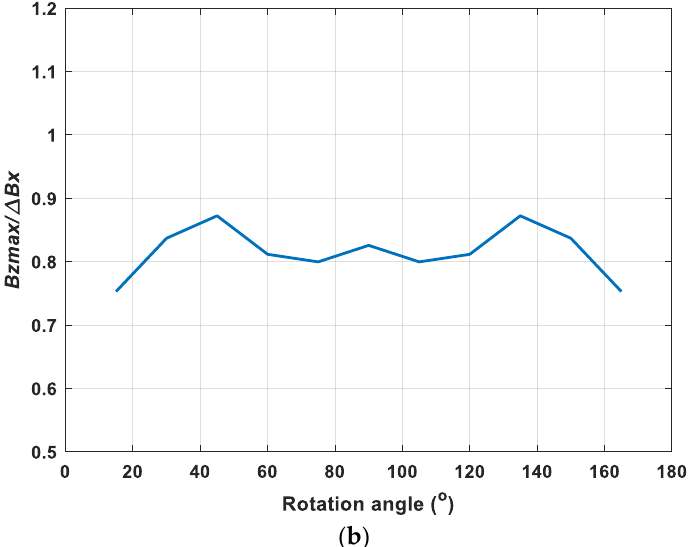
Figure 13. ( a ) The measured results of the magnetic B field. ( b ) The ratio of the maximum of the z component and the change of the x component under varying rotation angle.